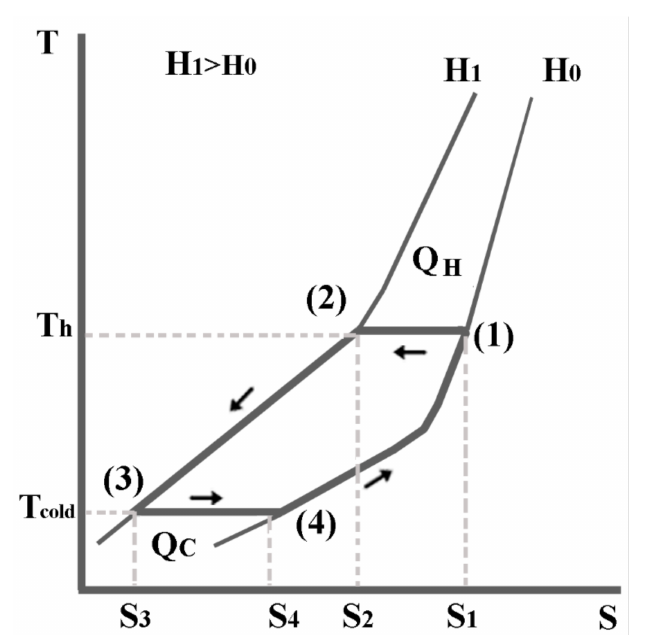
Figure 2. Ericsson cycle with